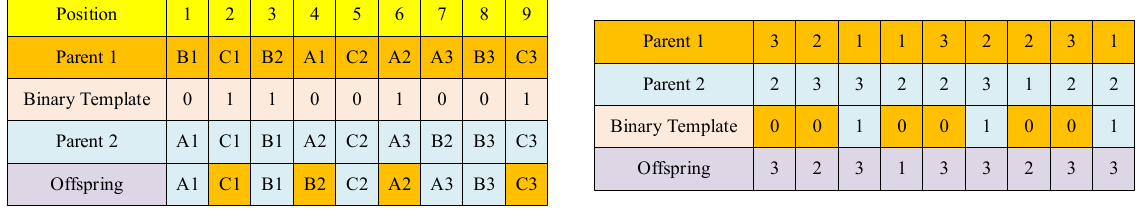
Fig. 3. Order Crossover with Repaired Offspring Fig. 4. Example of Uniform